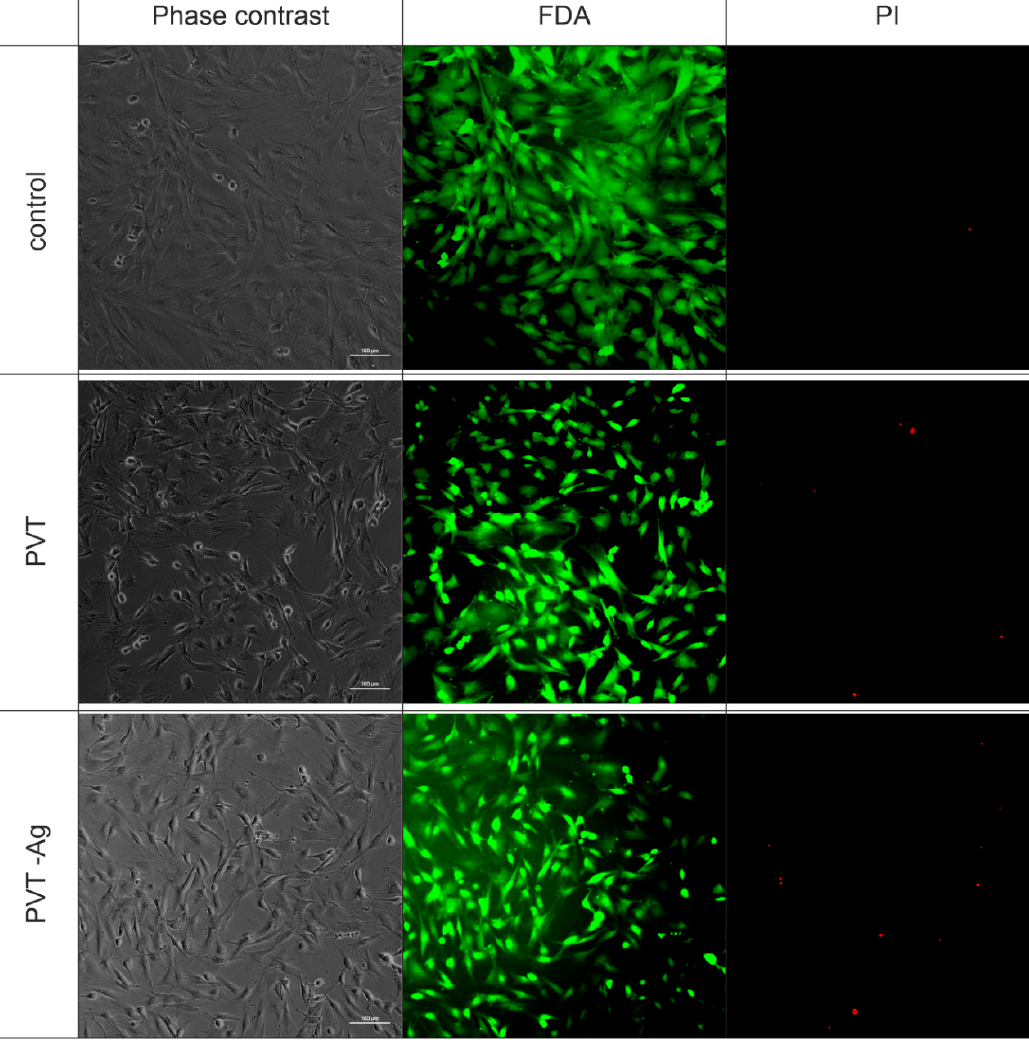
Figure 7. Incubation with fibroblasts for 24 h: control, PVT 16 µ g / mL, AgNPs nanocomposites (PVT-Ag) 16 µ g / mL. Phase contrast, fluorescence staining with fluorescein diacetate (FDA) (green) and propidium iodide (PI) (red). Scale bars 100 µm.